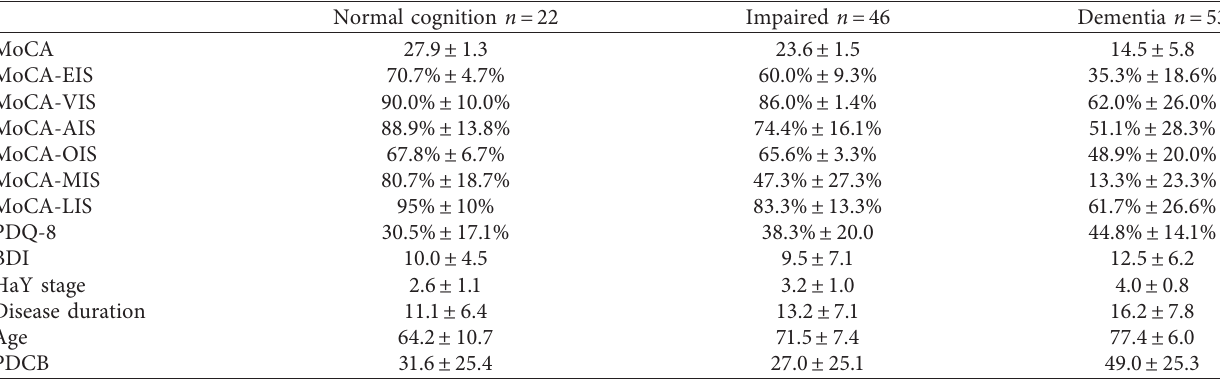
Table 2: Characteristics and distribution of MoCA subscores in PD patients with normal cognition, cognitive impairments, and patients suspicious for dementia.